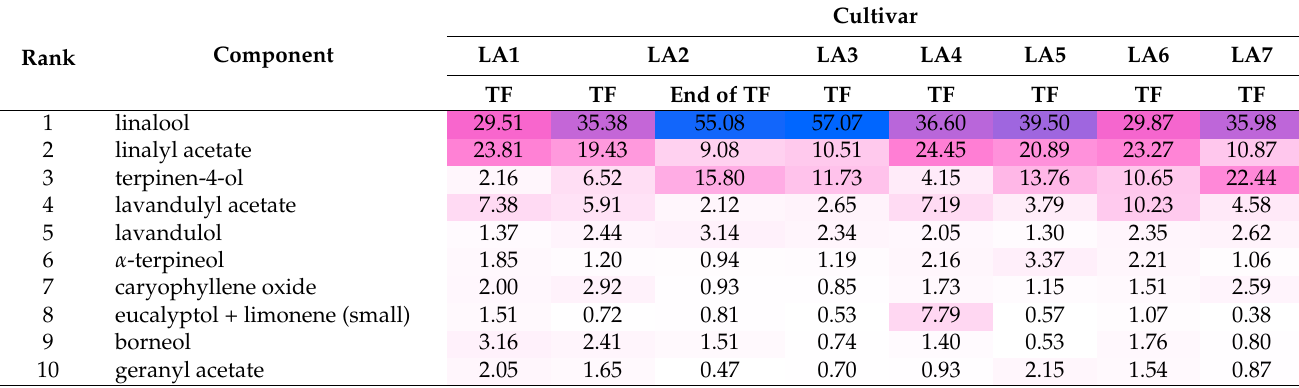
Table 3. The top 10 abundant components in essential oils of the studied L. angustifolia cultivars. The compounds are ordered according to the total sum of % area for all the cultivars. Numbers are relatives abundancies in %.